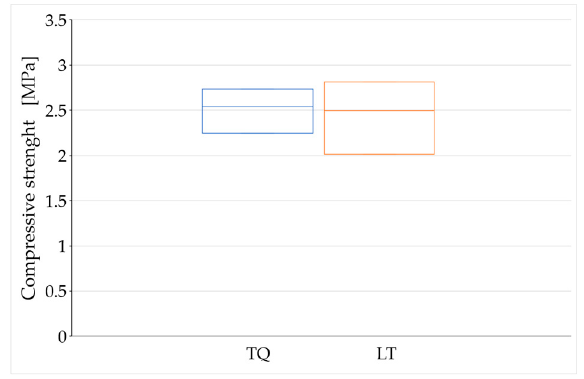
Figure 12. Minimum, average, and maximum values of compressive strength after 90 days of curing.